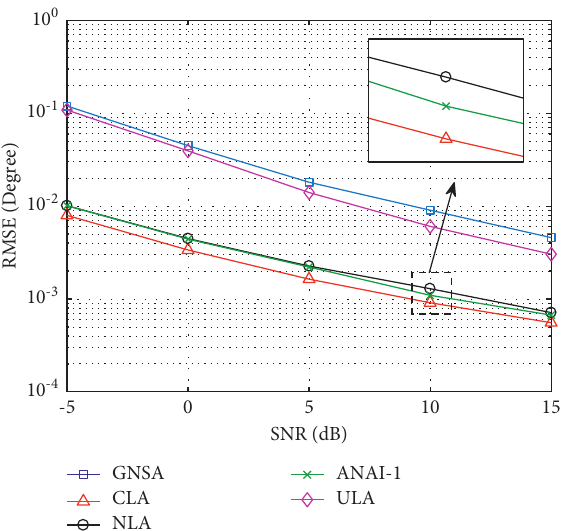
Figure 5: The RMSE versus SNR in different sparse arrays using spatial smoothing.